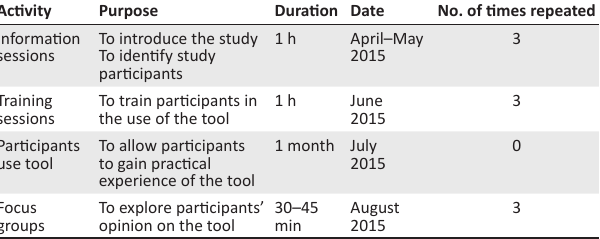
TABLE 1: An overview of study processes (created by